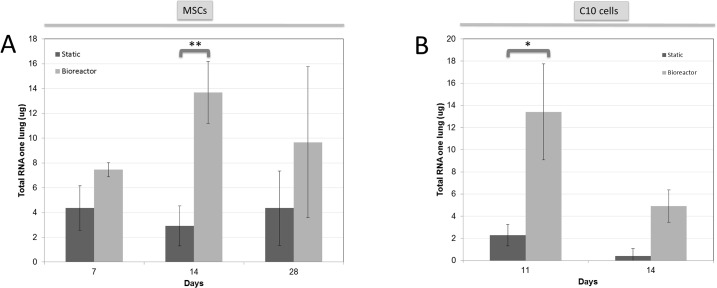
Total RNA levels of decellularized lungs recellularized with MSCs (A) or C10 cells (B) in static versus bioreactor conditions.For each condition, mean RNA levels +/- standard deviation for the left lung is presented. * p < 0.05, ** p < 0.01.